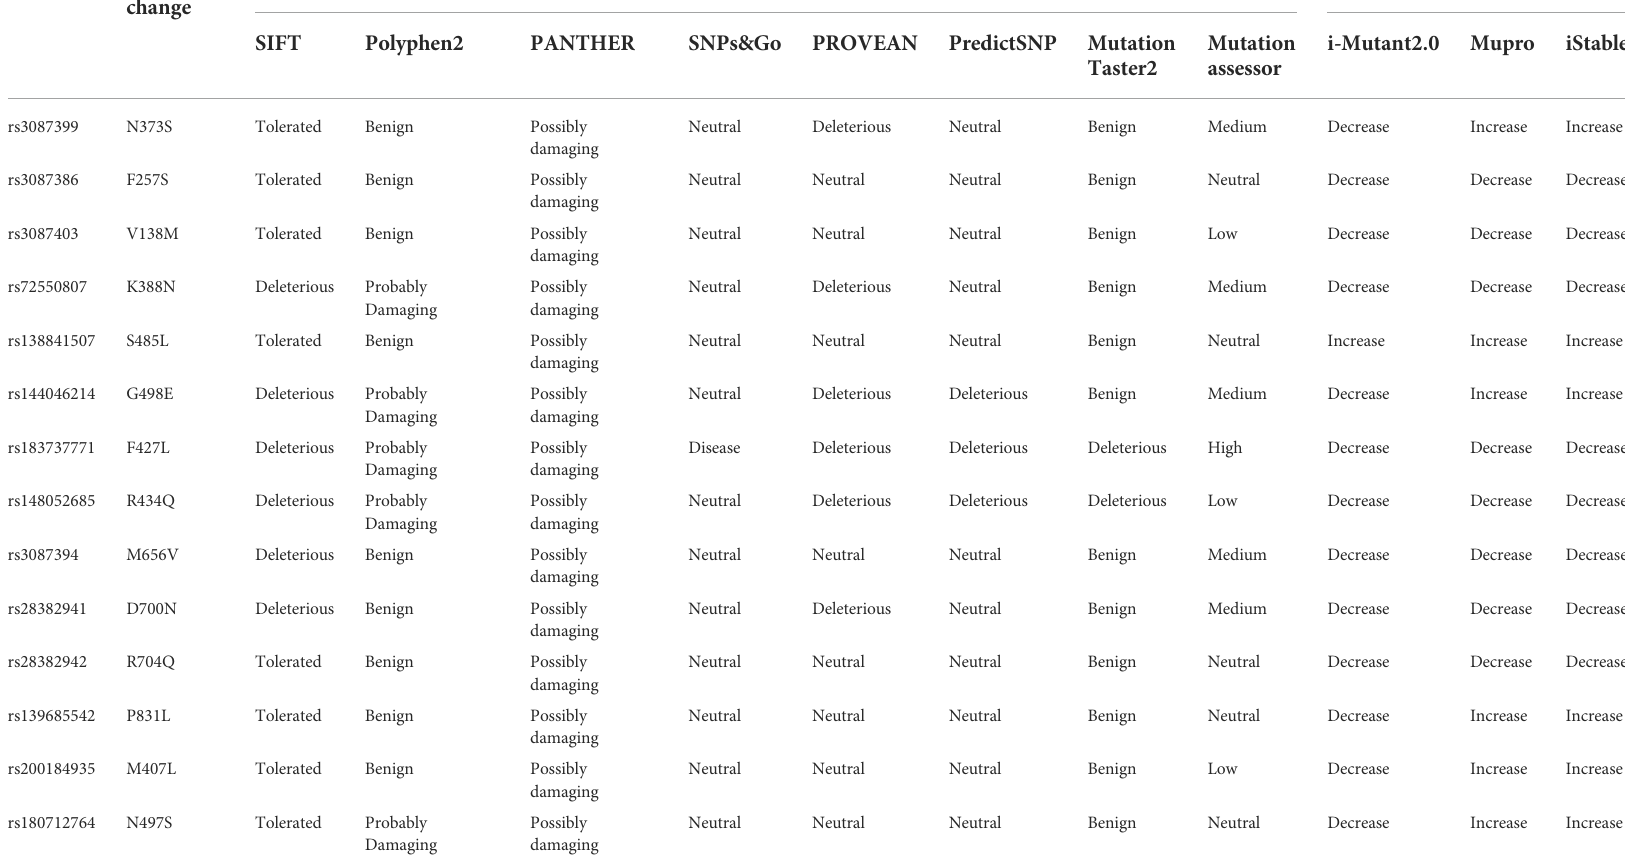
TABLE 1 High risk nsSNPs identi fi ed in silico programs and effect of nsSNPs on protein stability predicted by silico